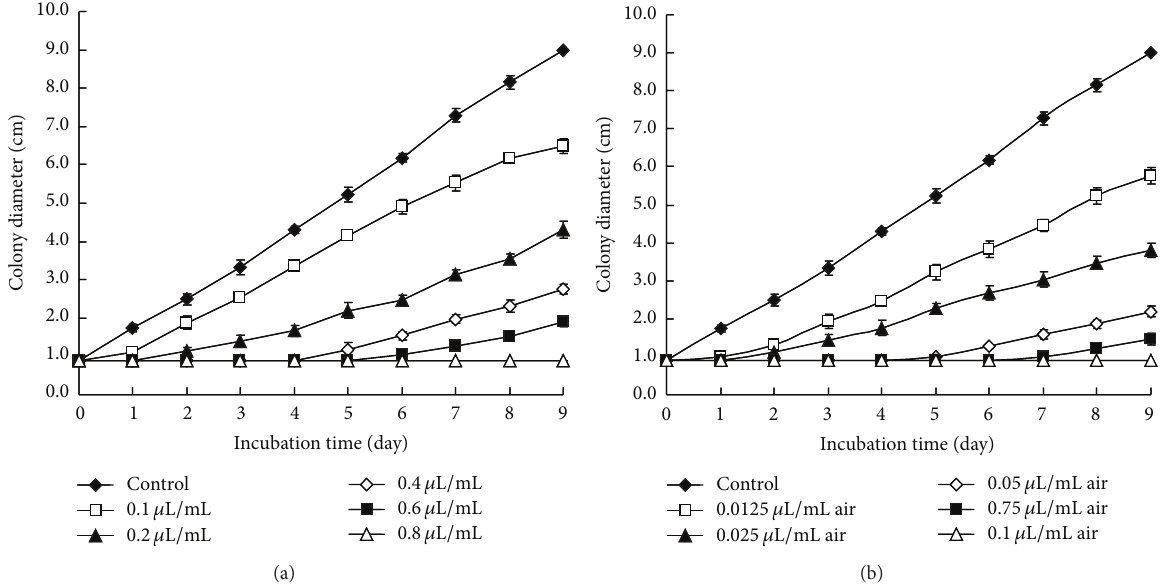
Figure2:Effectsofdifferentconcentrationsofcontact(a)andvapor(b)phaseofNELoncolonygrowthof A.flavus .Theplateswereincubated at a temperature of 28 ± 2 ∘ C for 9 days. Values are means ( 𝑛 = 3 ) ± standard deviations.